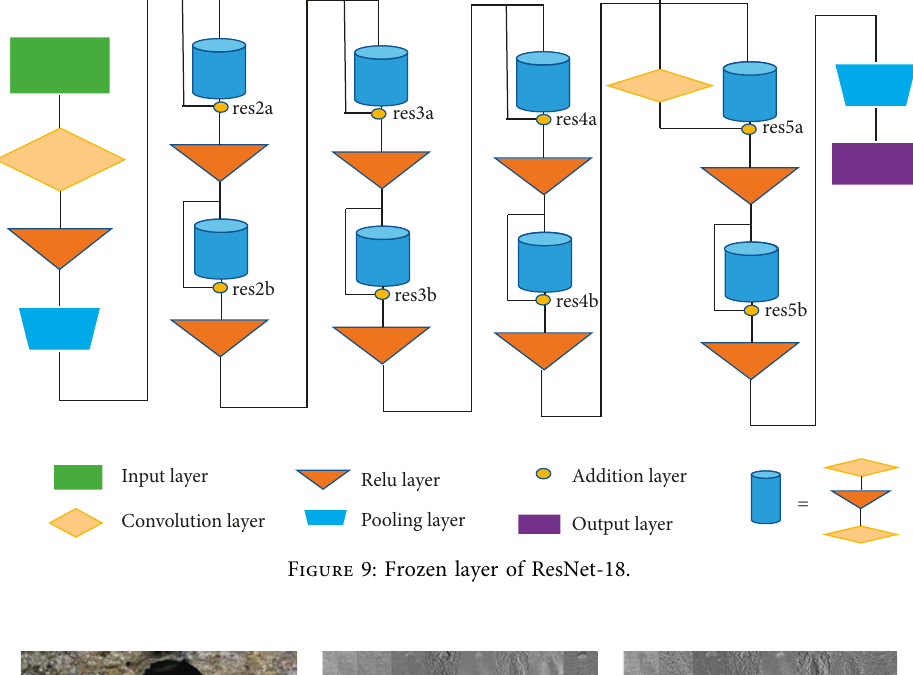
Figure 9: Frozen layer of ResNet-18.